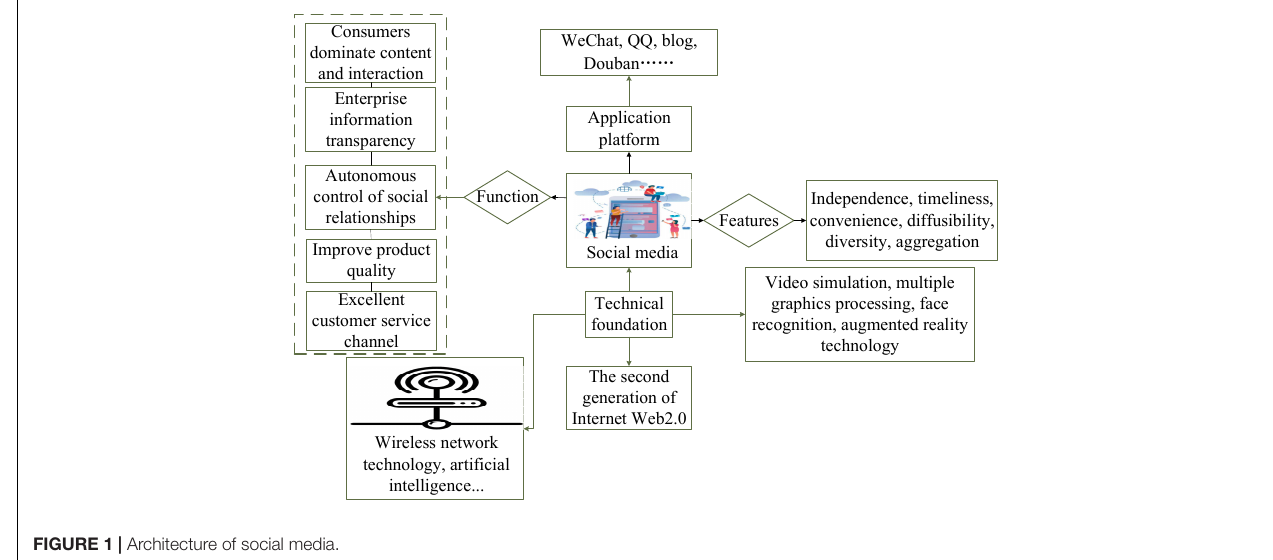
FIGURE 1 | Architecture of social media.